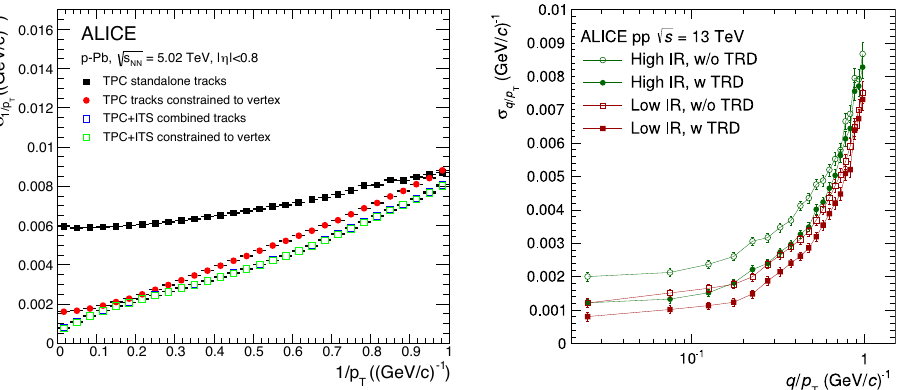
Fig.25. FractionoftracksmatchedbetweentheTPCandtheTRD(TPC–TRD)andfurther the TOF detector (TRD–TOF) as a function of transverse momentum in pp collisions at s =13 TeV . Fig. 23: The p T resolution for standalone TPC and ITS–TPC matched tracks with and without constraint to the ˘ Figure 2. Left: the p T resolution in p–Pb collisions for standalone TPC and ITS–TPC matched tracks vertex. Thevertexconstrainsignificantlyimprovesthe resolutionofTPC standalonetracks. ForITS–TPC tracks, Fig.27. Improvementofthe q _ p T resolutionindatawhenTRDinformationisincludedas ithasnoeffect(greenandbluesquaresoverlap). comparedwiththeperformanceoftrackingwithoutTRDinformationforvariousrunning with and without constraint to the vertex [2]. Right: improvement of the q / p T (inverse transverse scenarios. The labels low and high IR indicate interaction rates of 12 and 230 kHz, respectively. momentum scaled with the particle charge) resolution in data in pp collisions when TRD information is included in the tracking for various running scenarios. The labels low and high IR indicate Table 5 Typicalwidthofthetracklet-to-trackresidualsin y observedduringtheinternalalignment interaction rates (IR) of 12 and 230 kHz, respectively procedure.Theresidualsarebetweenatracklet(measuredbyasinglechamber)andtrack